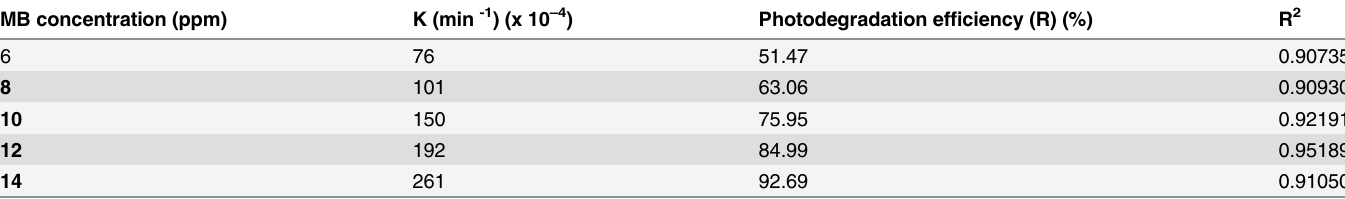
Table 2. The apparent rate constant ( k ), photodegradation efficiency (R) and adjusted R-square at different MB initial concentrations. MB concentration